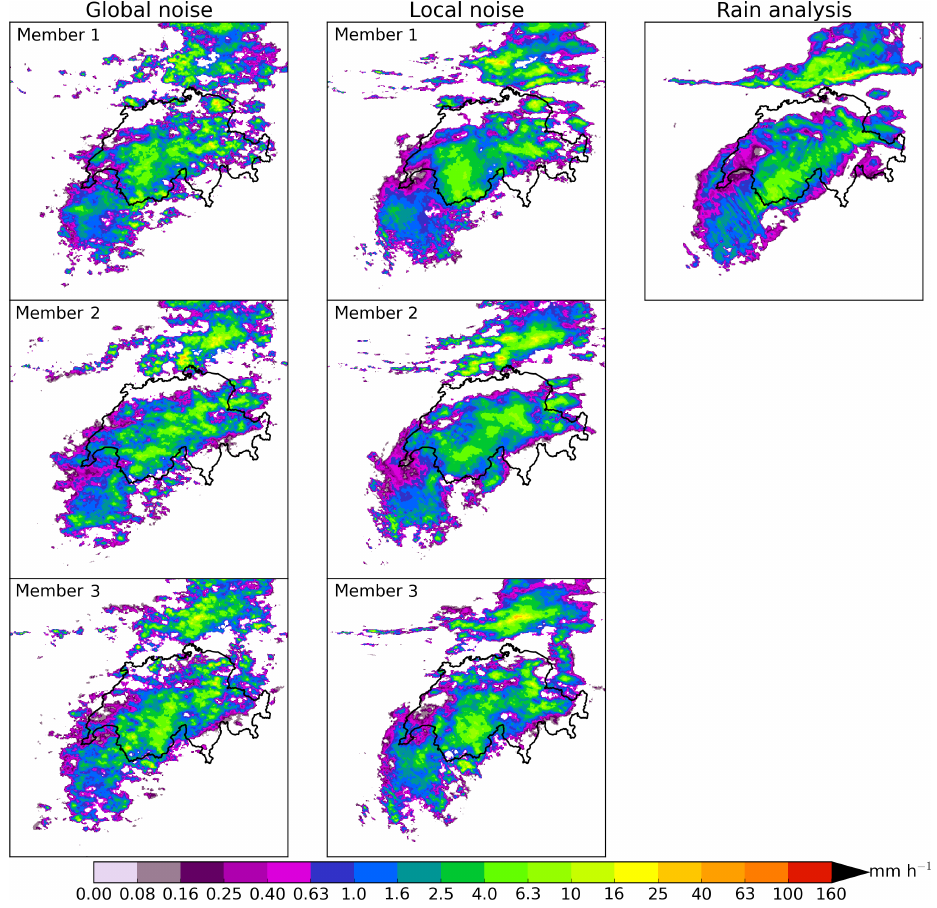
Figure 12. Three stochastic realisations conditioned to case study 1 (30 March 2015) after local adjustment at 64km resolution of correlated global FFT (left) and local SSFT (centre) Gaussian noise. The top right panel shows the actual observed field. Parameters of the local SSFT generator: window size = 128km, overlapping = 50%. The national borders of Switzerland are included as spatial reference (black